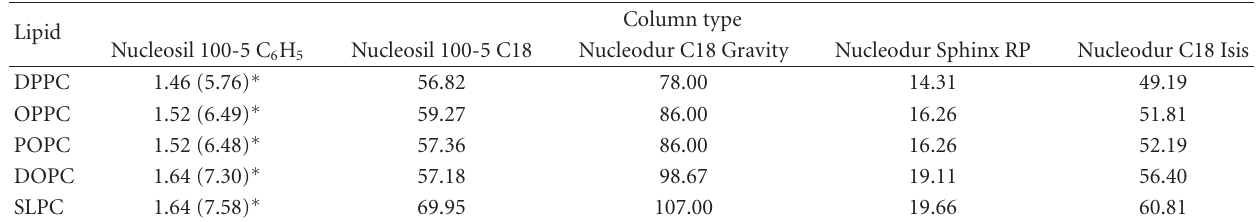
Table 1: Retention times of di ff erent PC-components with the same ECN on di ff erent reversed phase columns. Lipid